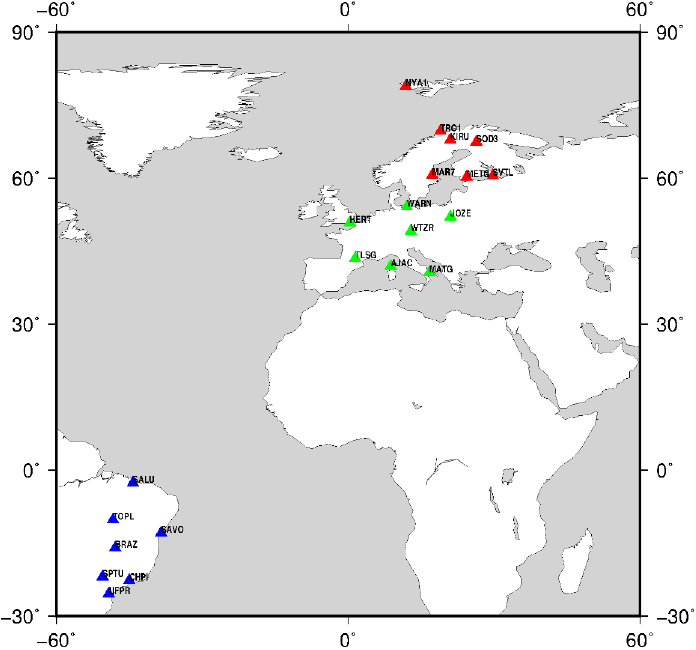
Figure 2. The IGS tracking stations of the high (red triangle), middle (green triangle), and low latitude networks (blue triangle).